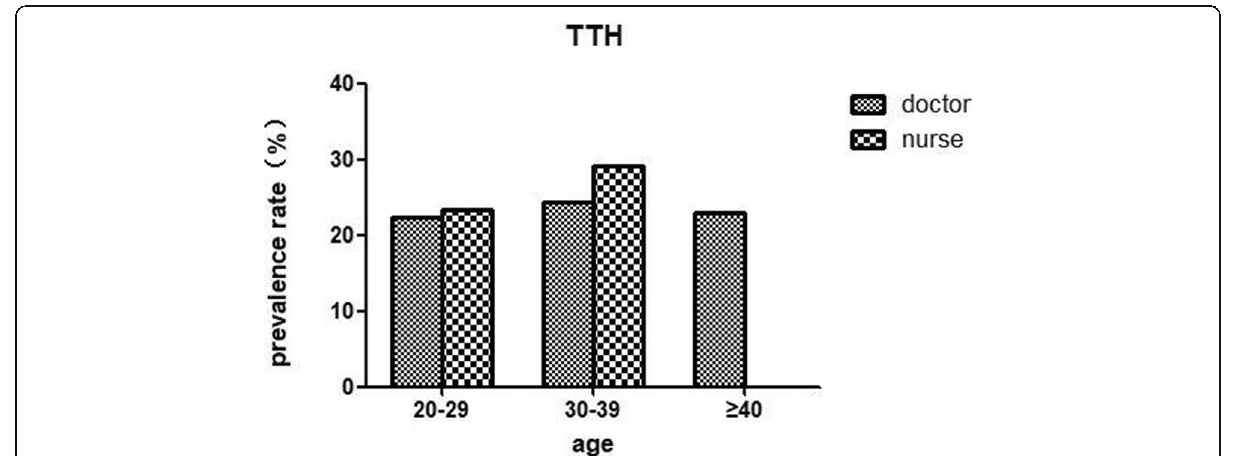
Fig. 4 Prevalence of TTH among doctors and nurses by